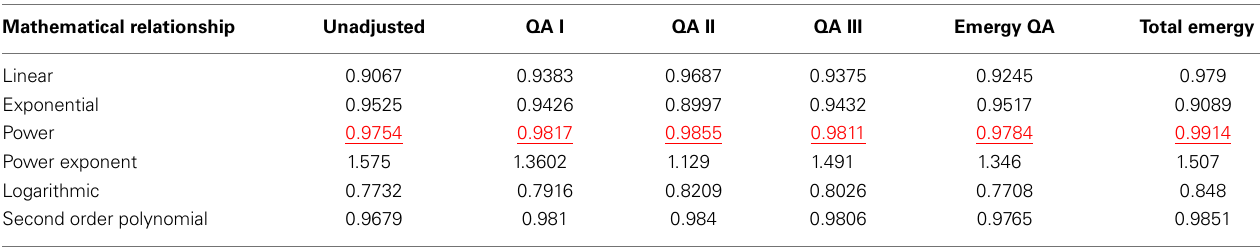
Table 3 |The R -squares of mathematical relationships between real GDP (Y) and measures of energy and quality adjusted (QA) energy consumed or total emergy used (X)